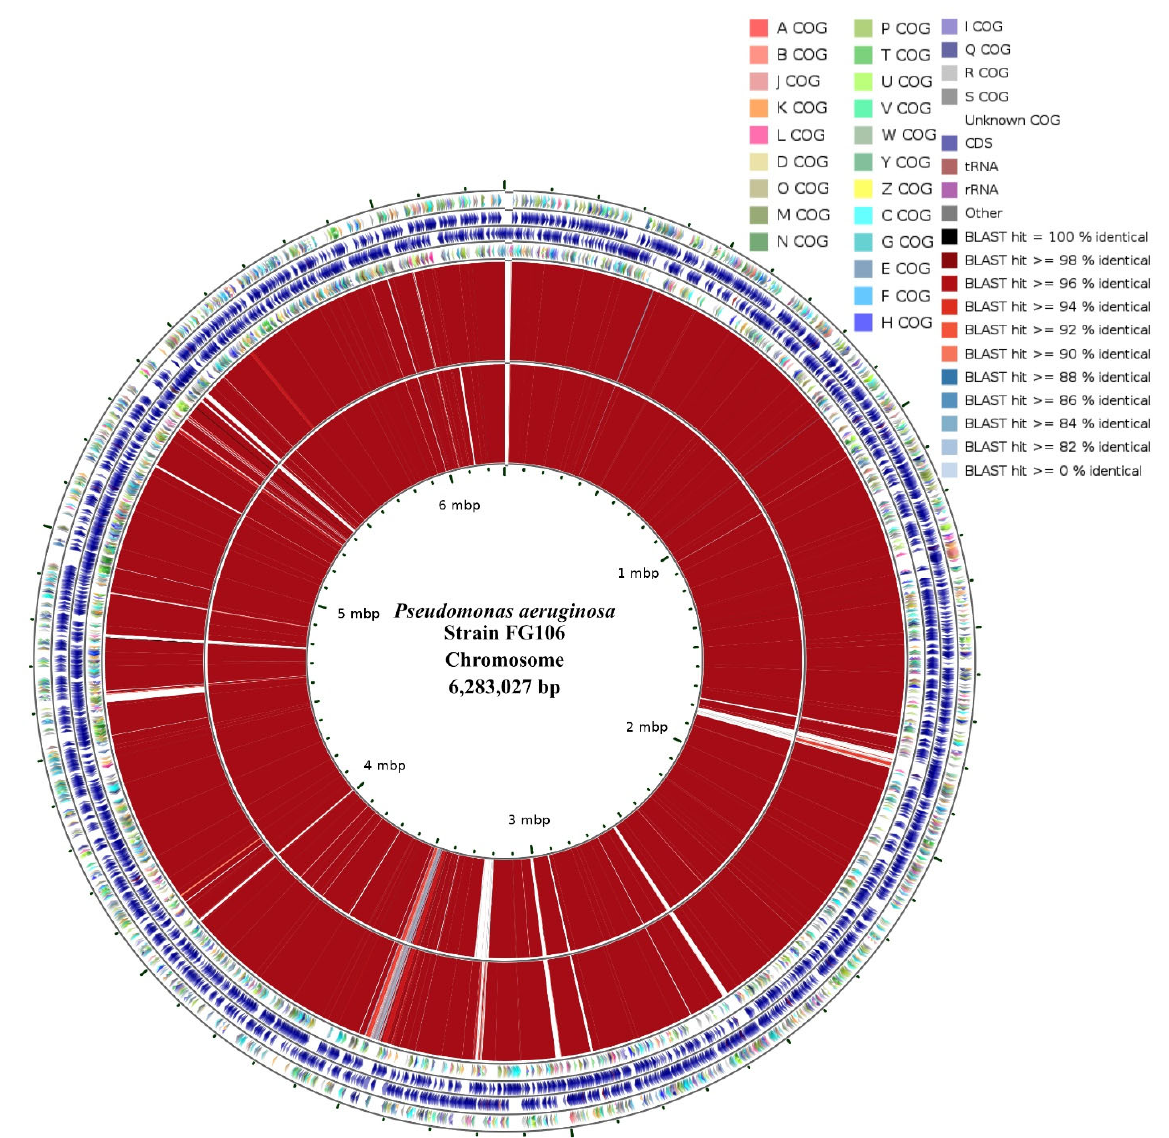
Figure 7. Circularized genome map of P. aeruginosa strain FG106 showing COG and genome com- parisons and DNA-vs.-DNA comparisons. From the outside to the center, the circularized sequence shows genes on the forward strand (colored by COG categories) and genes on the reverse strand (colored by COG categories). The DNA map was generated using BLAST hits obtained by comparing the FG106 (101) strain to two reference strains: P.aeru-DSM.50071 (NZ_CP012001) and P.aeru-M18 (NC_017548), indicated in the two inner circles.